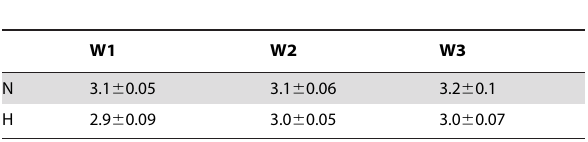
Table 3. Mean ( 6 SE) intensity of additional training outside the experimental design of each training week for Normoxic (N; n = 8) and Hypoxic (H; n = 10)